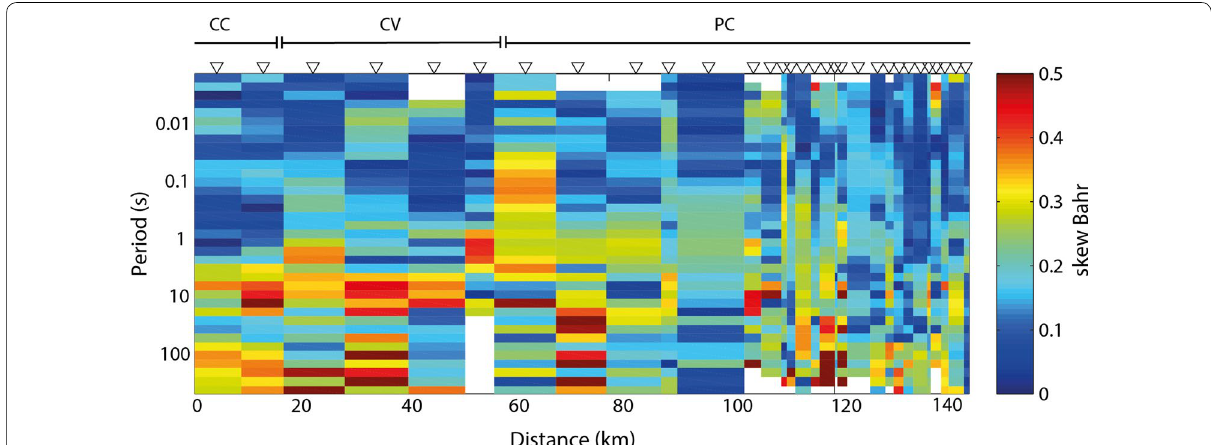
Fig. 2 Profile showing skew values according to Bahr (1988). Each column represents an interpolation of the skew value between two sites. The width of the columns considers the spacing between the sites along the profile, resulting in a more detailed image of this parameter to the East. Low skew (< 0.3) indicates relatively 2D